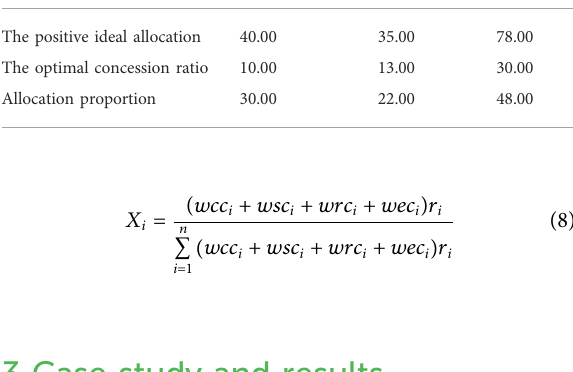
TABLE 3 First stage of water allocation results in the Tigris-Euphrates River.